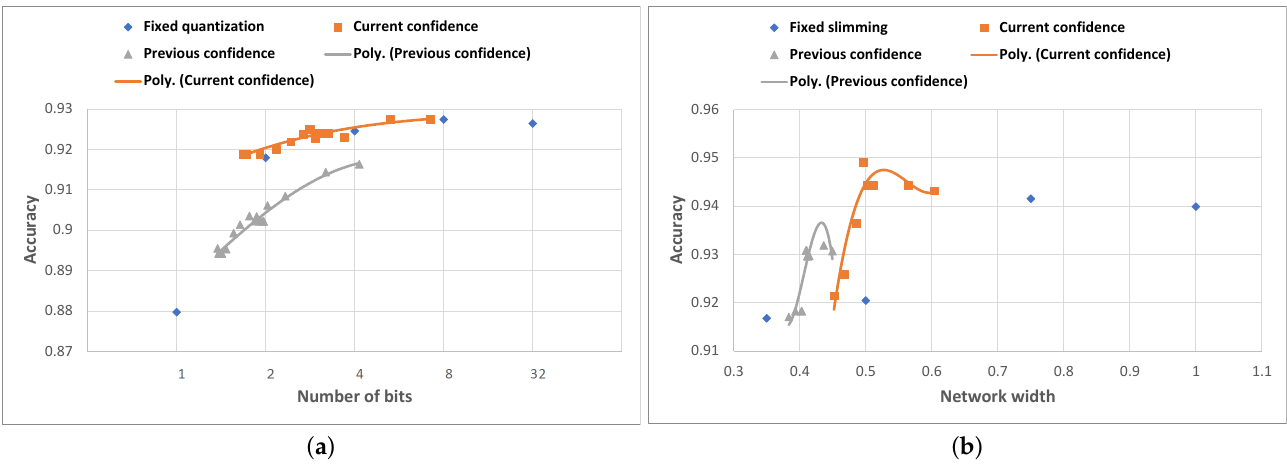
Figure 9. Results of the compression level selection algorithm based on softmax confidence. The blue line shows the accuracy that can be achieved with static compression. ( a ) Any-Precision. ( b )